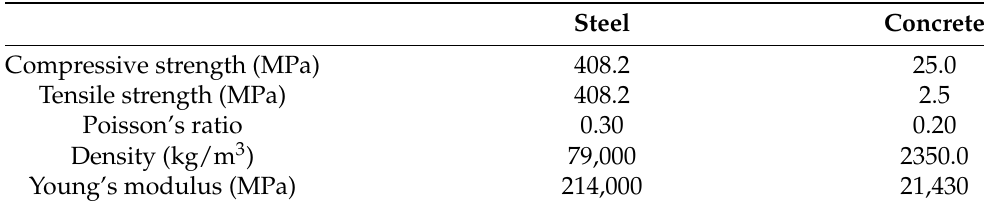
Table 3. Material constants used in the analysis with different installation conditions.